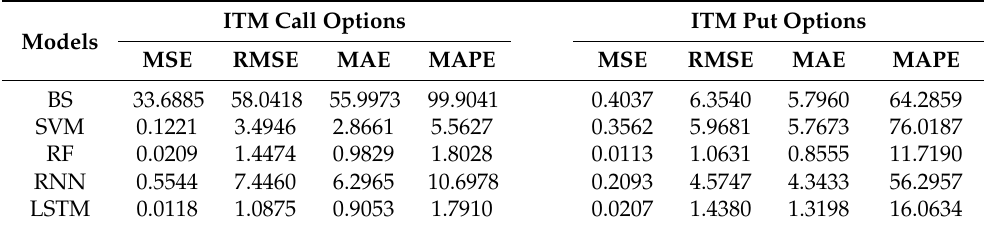
Table 8. Pricing error of ITM options estimated using different models when using realized skewness. Models